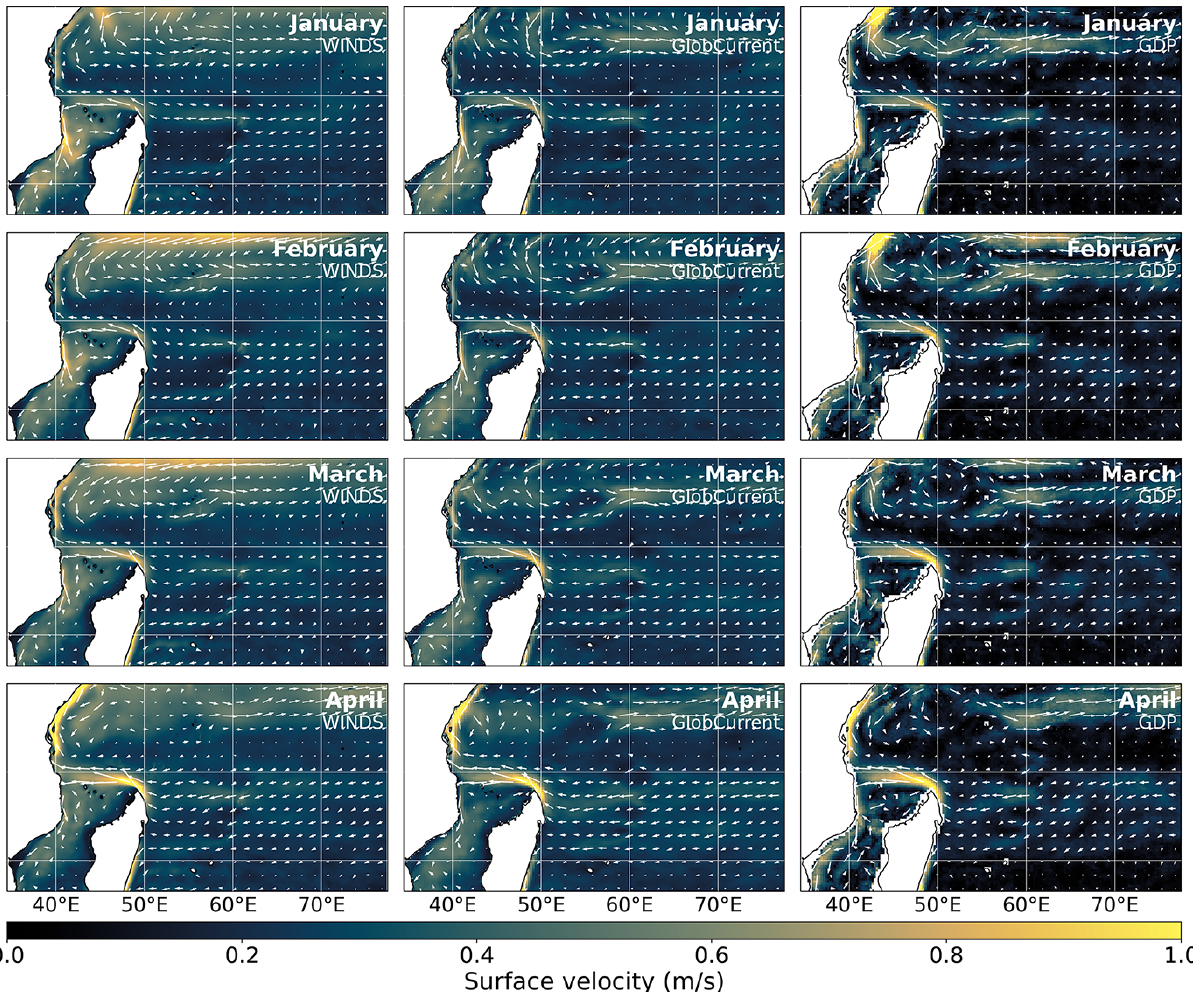
Figure 2. Monthly climatological surface currents (1993–2020) from WINDS (left), Copernicus GlobCurrent Surface (centre), and Global Drifter Program-derived near-surface currents (right) for January to